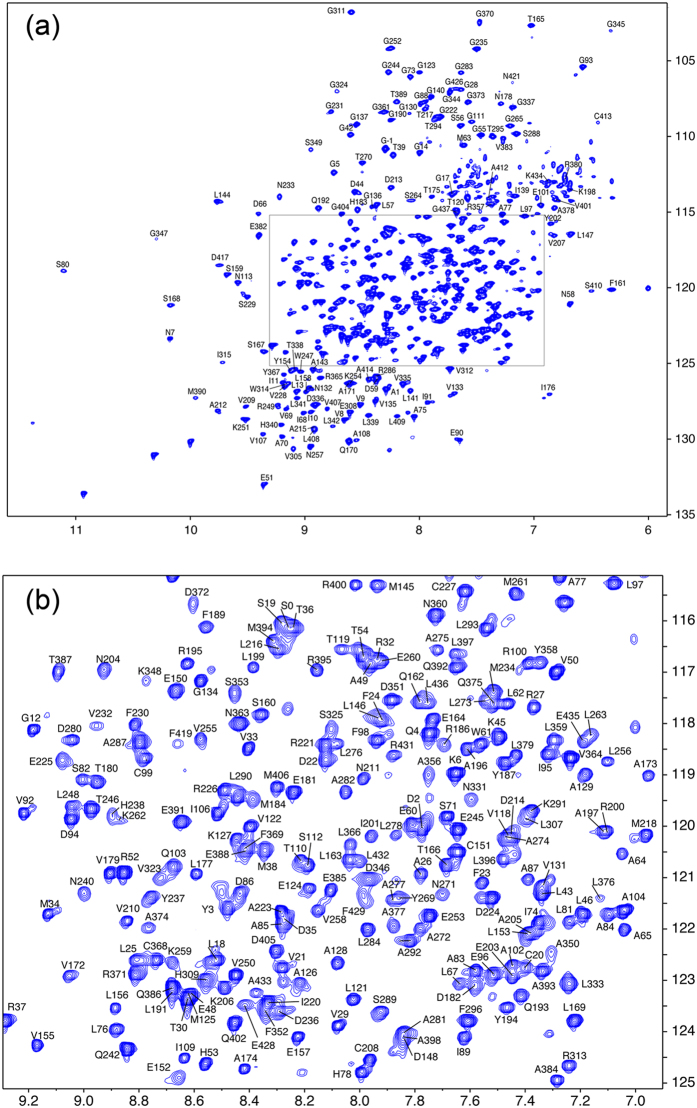
Backbone resonance assignment of 2H13C15N-labeled full-length MurD.(a) 1H15N-HSQC with assignments. (b) Expanded view of the region indicated by a box in (a).